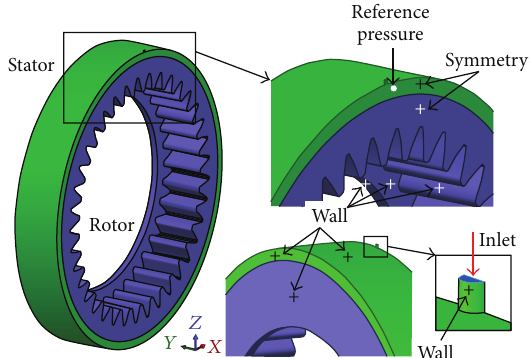
Figure 6: Computational domain of reference geometry.